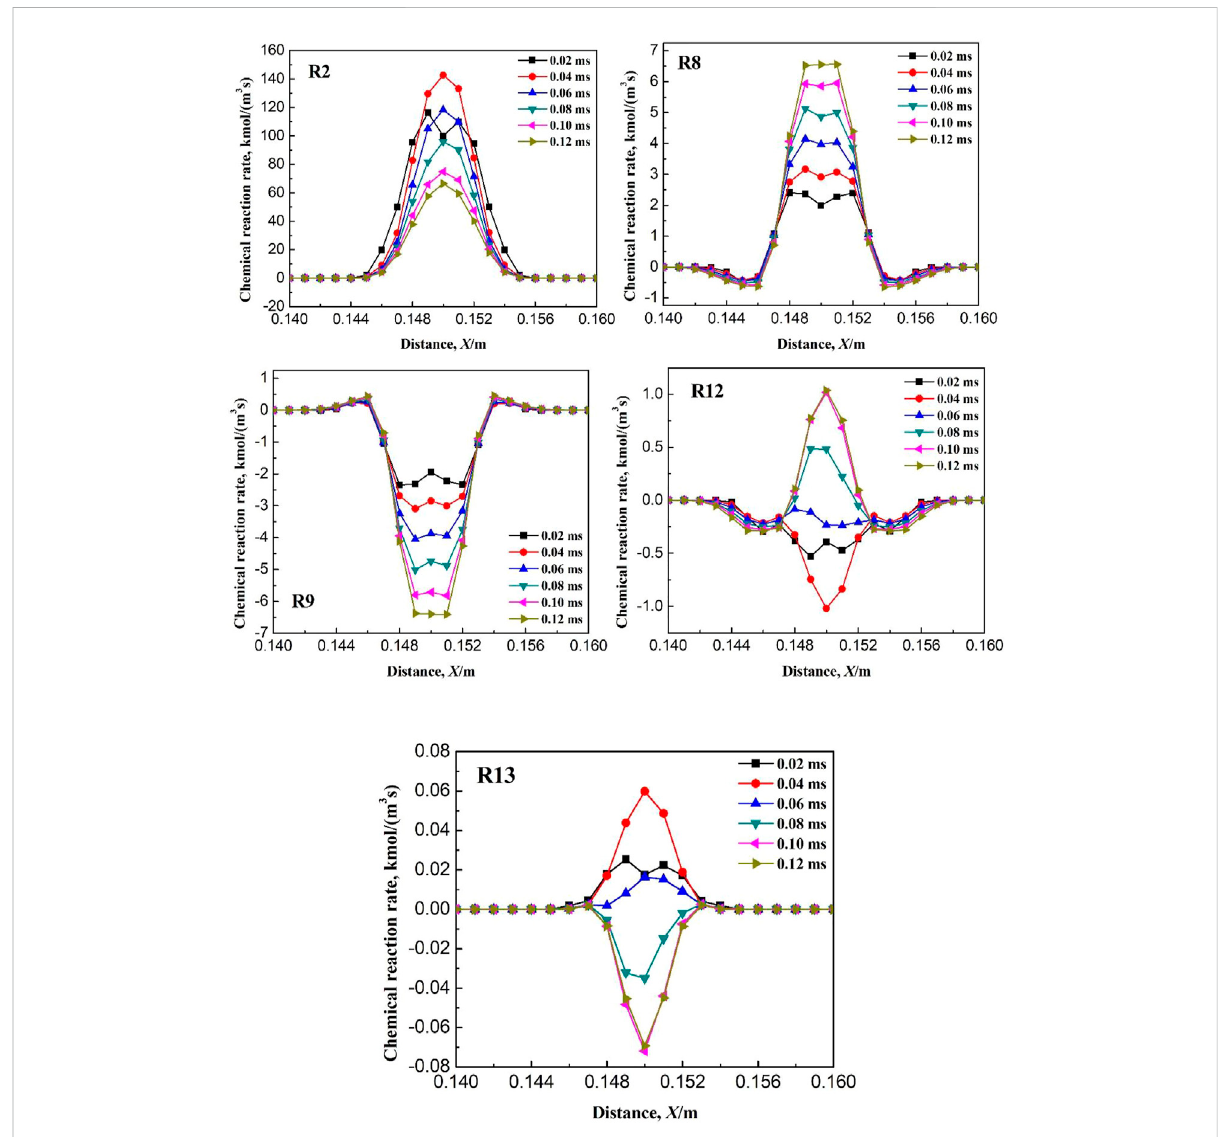
FIGURE 16 Variation of kinetic rate of elementary reactions with time when ignition radius is 4.6